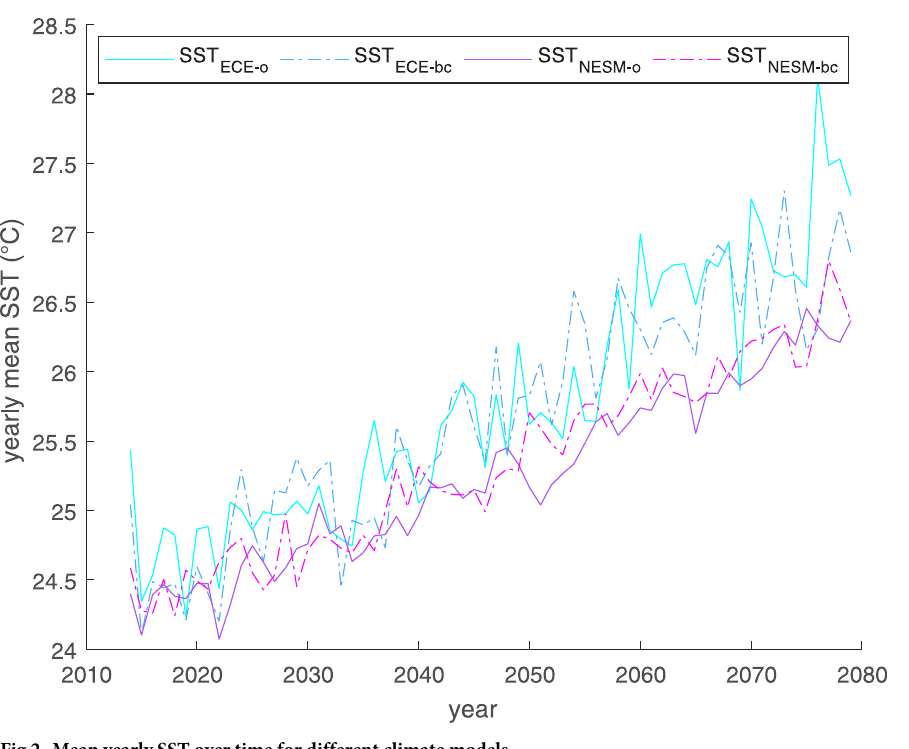
Fig 2. Mean yearly SST over time for different climate